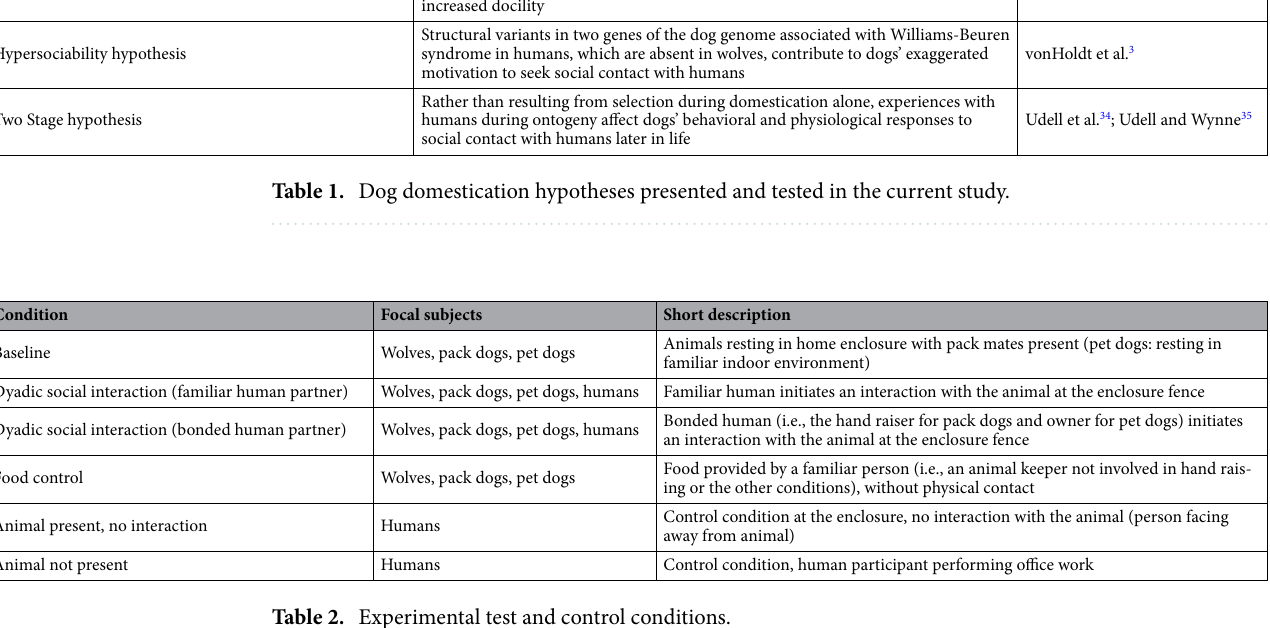
Table 2. Experimental test and control